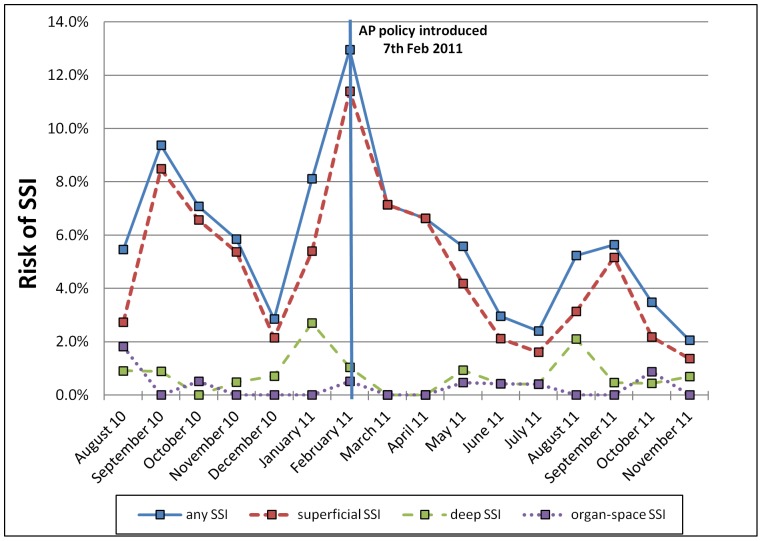
Monthly risk of SSI in Thika Hospital, 2010–11.